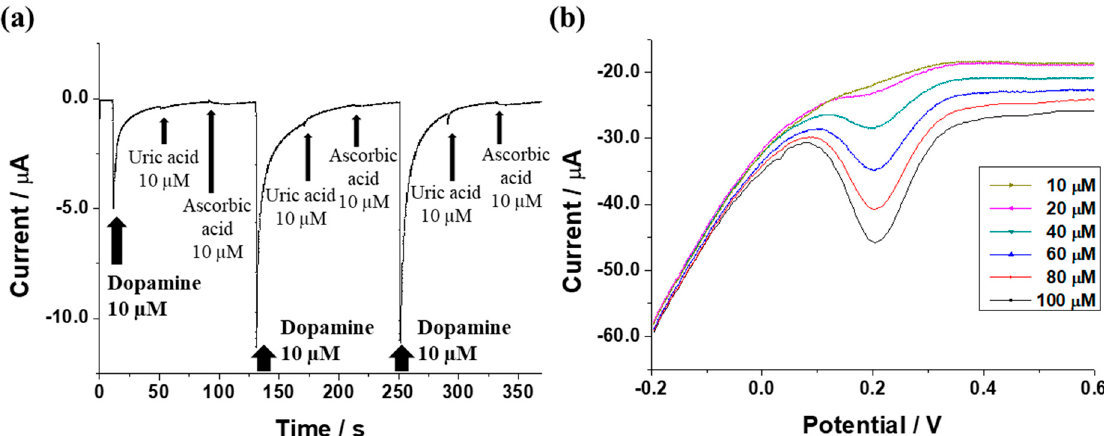
Figure 5. ( a ) Amperometric i-t measurement with the continuous addition of 10 μ M of each of dopamine, uric acid and ascorbic acid; ( b ) DPV for the concentration of dopamine ranging from 10 μ M to 100 μ M in the presence of 50 μ M of both uric acid and ascorbic acid.